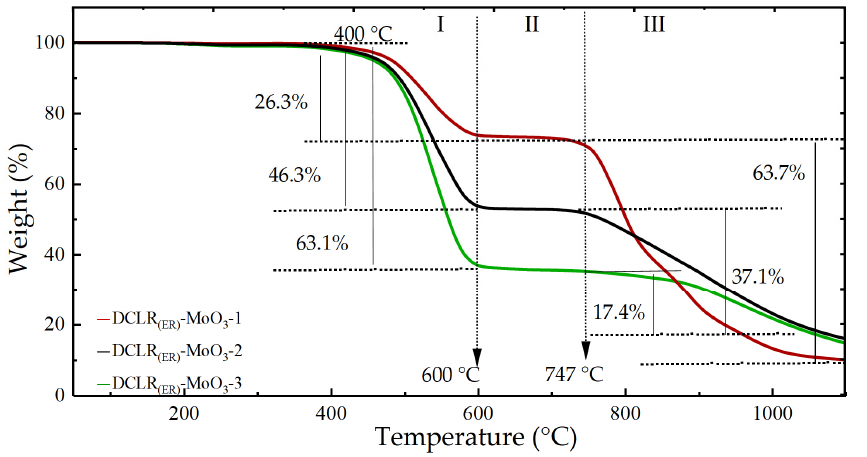
Figure 5. TG curve of DCLR (ER) -MoO 3 Pyrolysis.